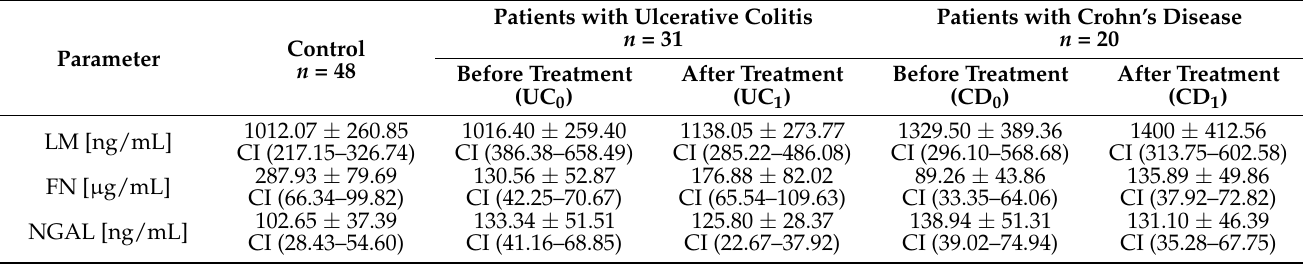
Table 3. Comparison of serum laminin (LM), fibronectin (FN) and neutrophil gelatinase-associated lipocalin (NGAL) concentrations in patients with UC and CD at baseline and after a year of treatment.